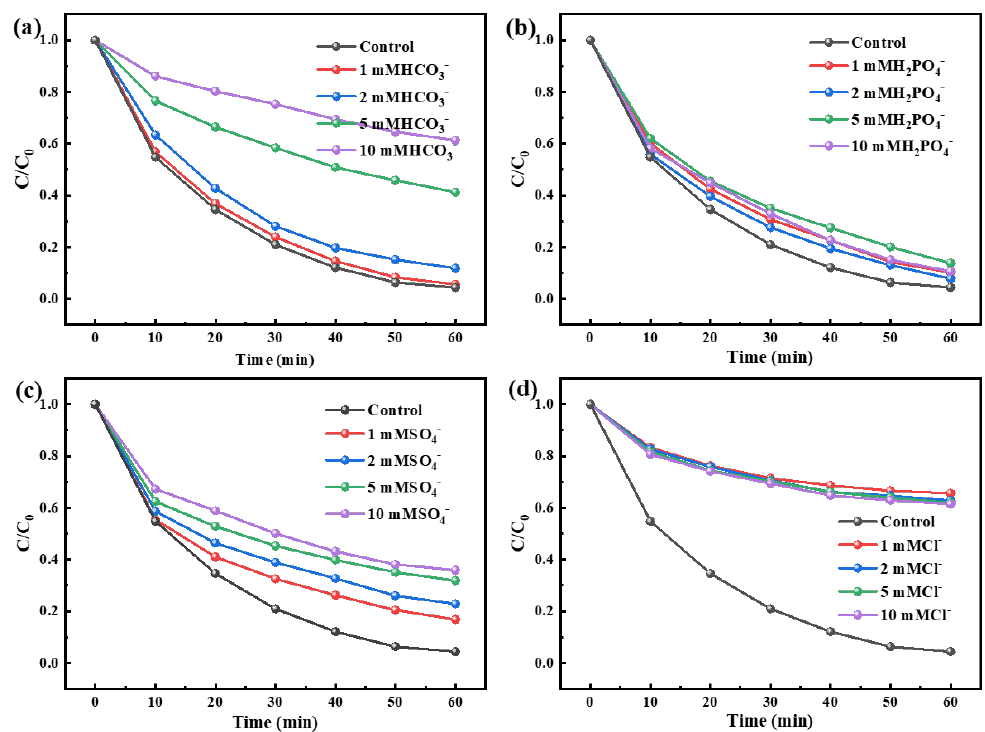
Figure 7. The effects of different concentrations of coexisting anions HCO 3 − ( a ); H 2 PO 4 − ( b ); SO 42 − ( c ); and Cl − ( d ) on the degradation effect of ibuprofen (temperature = 25 °C, pH = 4.5, PMS concentration = 0.7 mM, catalyst loading = 0.3 g/L, IBU concentration = 10 mg/L).